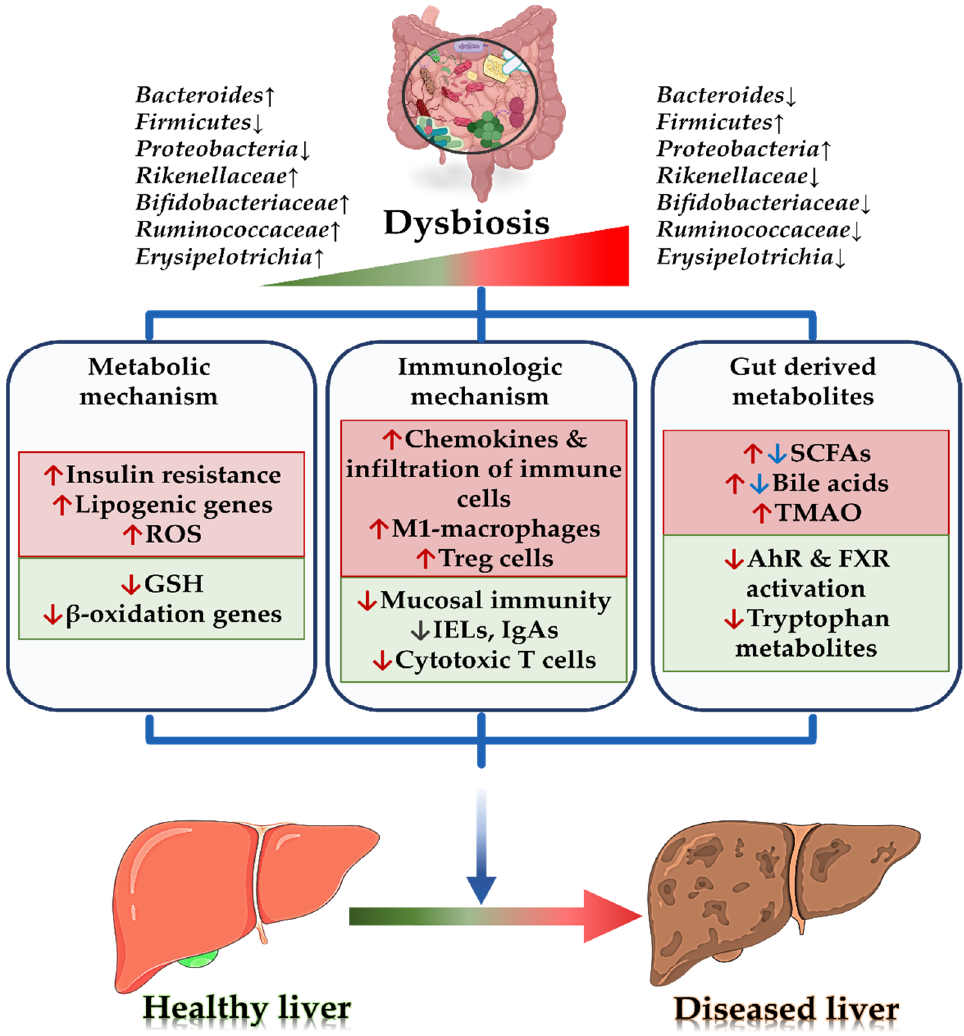
Figure 1. Different mechanism involving gut microbiota in pathophysiology of non-alcoholic liver disease. Abbreviations: ↑ indicates an increase in the condition or level; ROS, reactive oxygen species; GSH, glutathione; Treg, regulatory T cells; IELs, intraepithelial lymphocytes; IgAs, immunoglobulin A; SCFAs, short-chain fatty acids; TMAO, trimethylamine N-oxide; AhR, aryl hydrocarbon receptor; FXR, farnesoid X receptor.